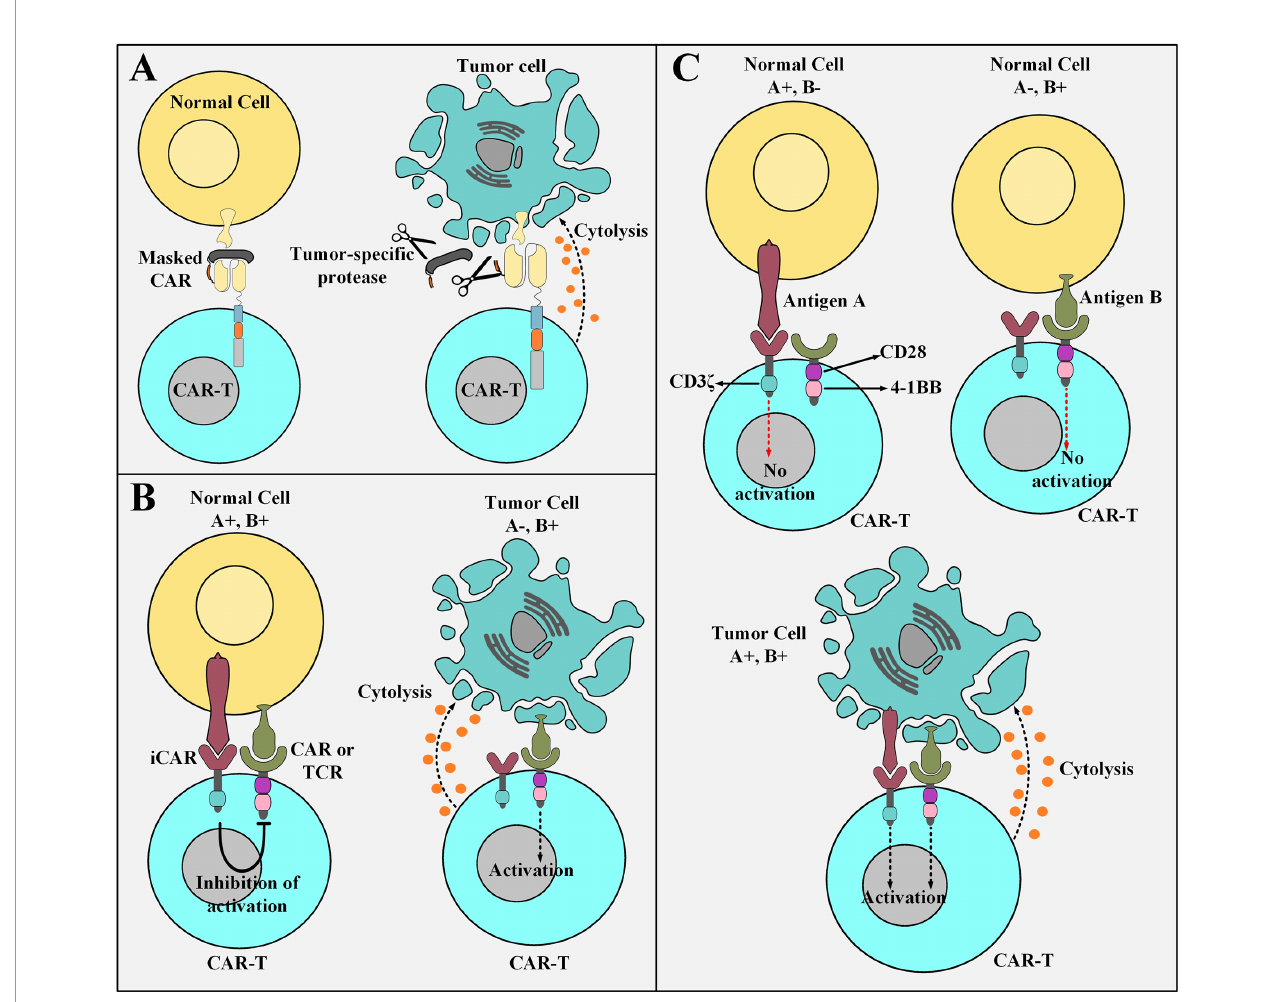
FIGURE 3 | Elaborate strategies for tackling the on-target off-tumor toxicity of CAR T cells. (A) Masked CAR T cells and their mechanism of action. Masked CAR T cells are unable to cytotoxically attack healthy cells because their targeting domains are veiled. In the tumor microenvironment, the masking peptide is dissociated due to the presence of tumor-speci fi c proteases. This phenomenon results in the recognition of the tumor cells by masked CAR T cells leading to the cytolysis of the tumor cells. (B) iCAR T cells and their mechanism of action. iCAR T cells are cytotoxically inert while encountering healthy cells simultaneously expressing their inhibitory and activatory antigens. Upon encountering tumor cells that only express the activatory antigen and are de fi cient in the expression of the inhibitory antigen, iCAR T cells are activated to carry out their tumoricidal effects. (C) The logic-gated CAR platform and its mechanism of action. Logic-gated CAR T cells require the presence of two antigens for their activation and triggering of cytotoxic effects. This strategy increases their safety index while encountering healthy tissues expressing one of the antigens. CAR-T, chimeric antigen receptor T cell; iCAR, inhibitory CAR; TCR, T cell